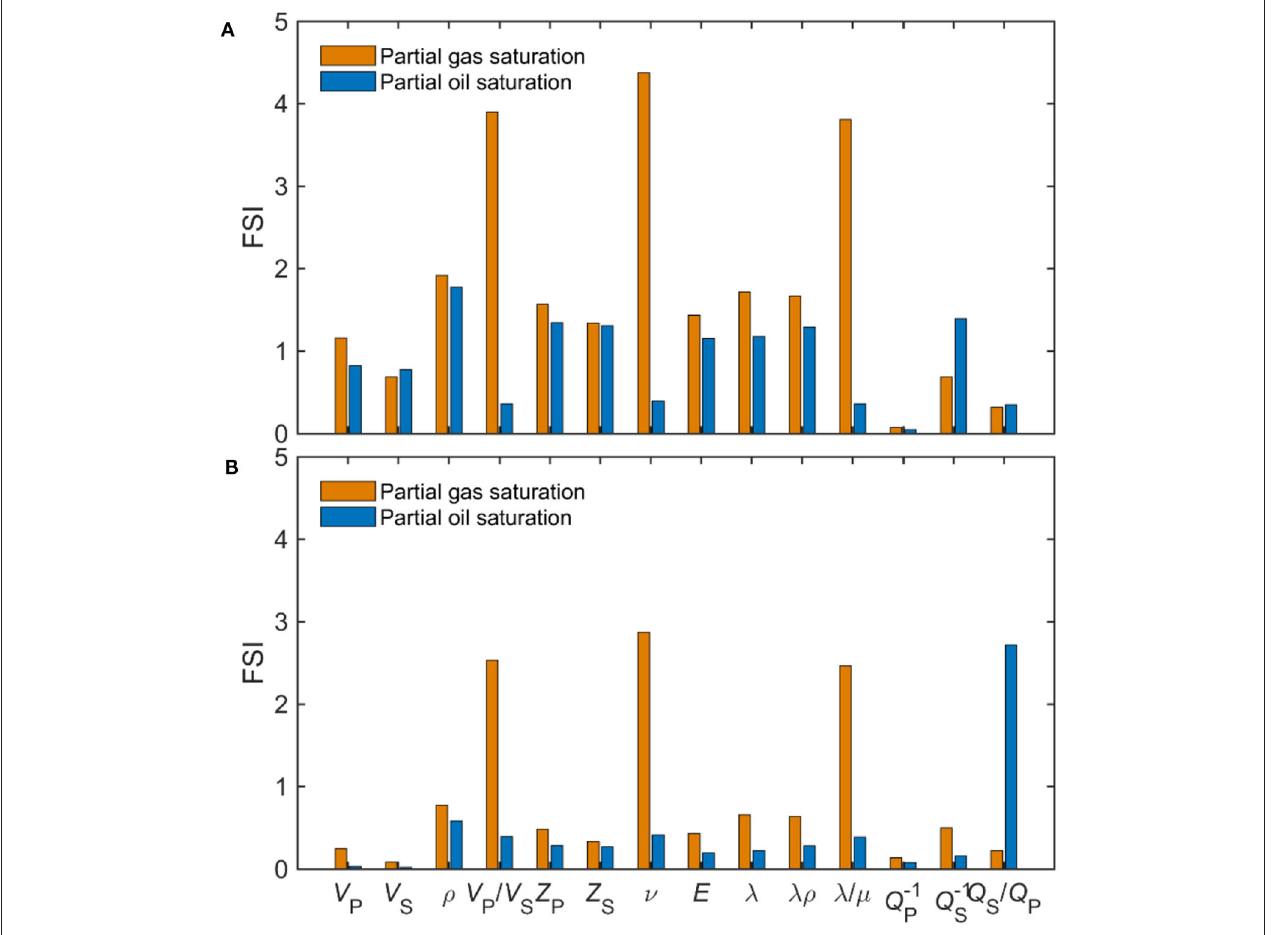
FIGURE 5 | FSI for siltstones (A) and dolomites (B) at partial